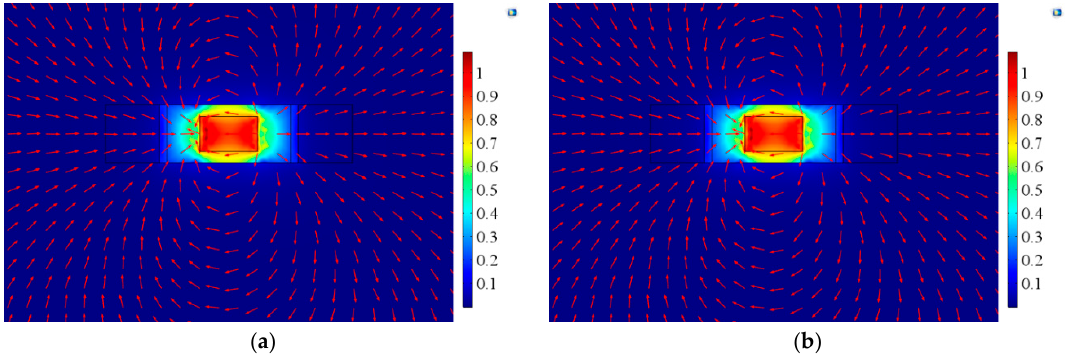
Figure 18. Magnetic flux distribution on ( a ) the upper and ( b ) lower surfaces of Terfenol-D under two NdFeB permanent magnets.